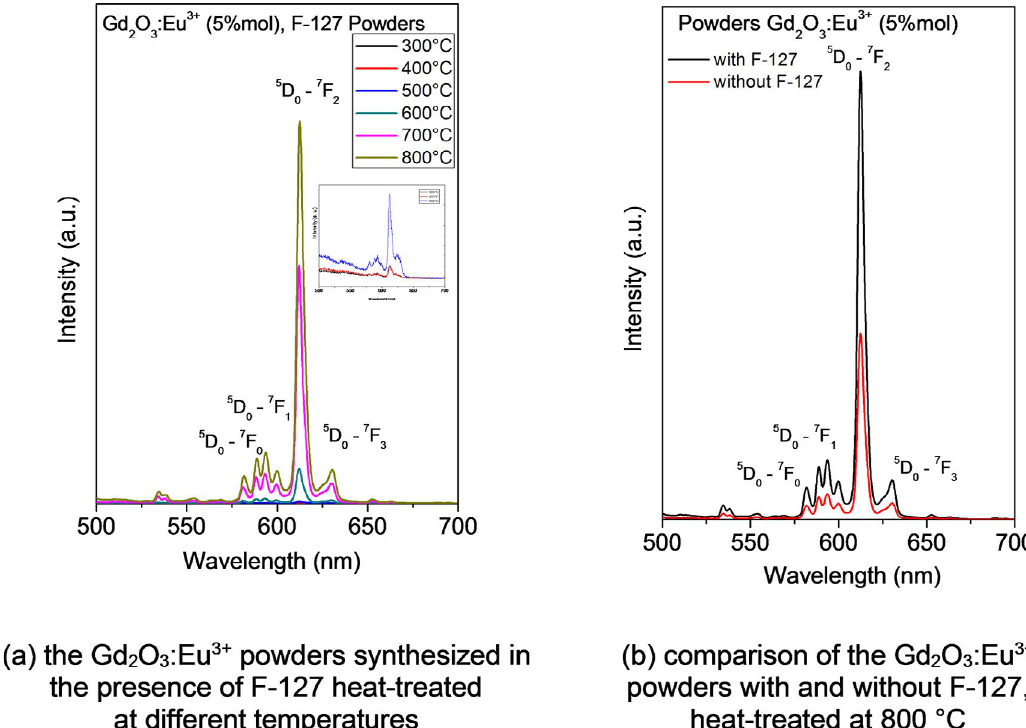
O :Eu 3+ powders synthesized in the presence of F-127 heat-treated at different temperatures and 2 3